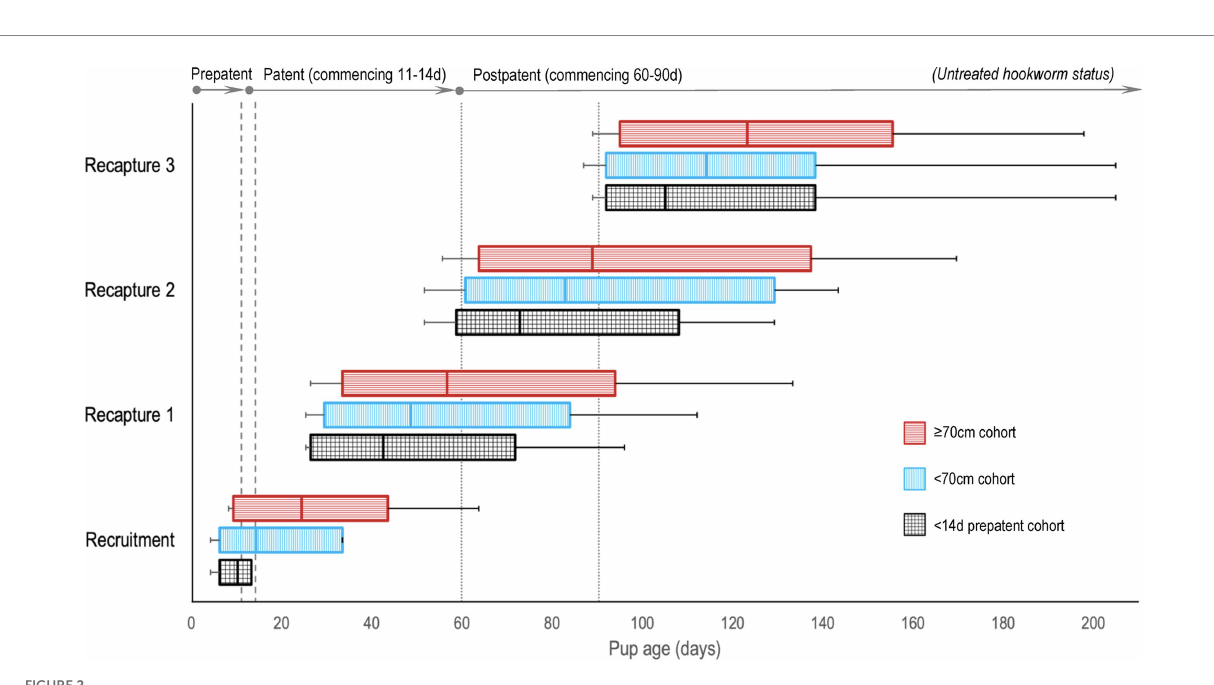
FIGURE 2 A comparison of Australian sea lion pup ages at recruitment and recaptures for the three age cohorts, relative to anticipated hookworm status in untreated pups. Patent hookworm infection develops from approximately 11–14 d of age (patency onset range – indicated by the vertical dashed lines), and infection is naturally cleared from approximately 60–90 d of age (patency termination range – indicated by the vertical dotted lines) (20). Boxes indicate the interquartile range for pup age with the median value marked (most distributions were right skewed), and the horizontal lines represent pup age range (minimum to